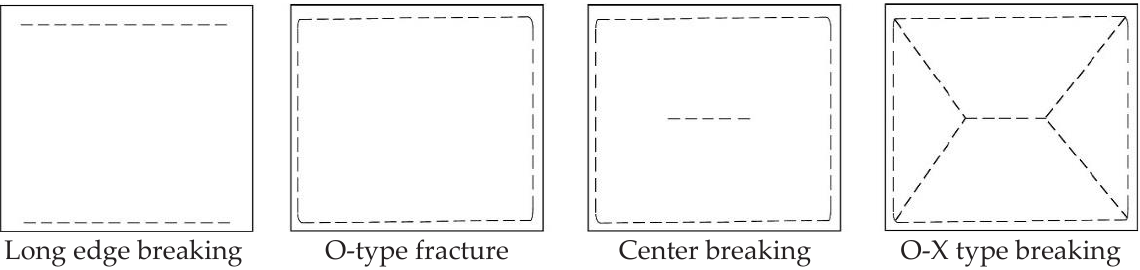
Figure 10. Roof O-X type breaking evolution process.